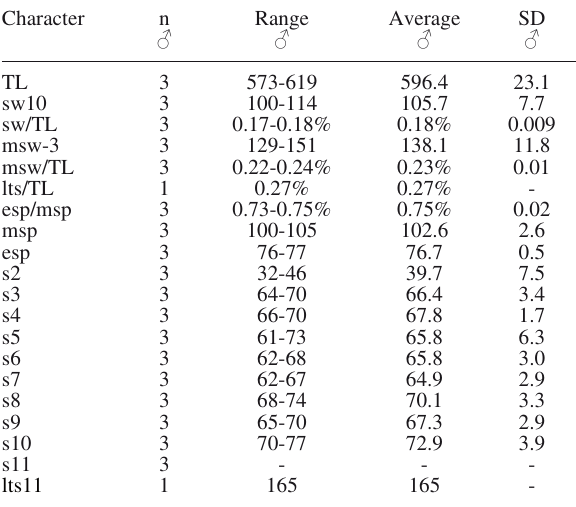
t able 4. – Summary of location of setae and sensory spots in Pycno- phyes chalgap n. sp. arranged by series. LD, laterodorsal; lts, lateral terminal spines; LV, lateroventral; m, character trait assumed to be male condition of sexually dimorphic character; ps, penile